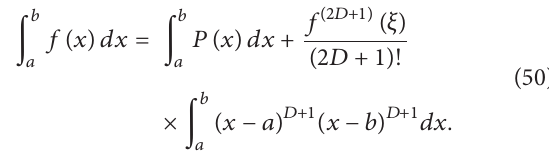
ONC for classical open numerical quadrature rule. ONC1 for open numerical quadrature with derivative at all interior points. ONC2 for open numerical quadrature with derivative at all points including endpoints. ONC3 for open numerical quadrature with derivative used only at interior endpoints. ONC4 for open numerical quadrature with derivative used only at exterior endpoints. Table 1 compares the coefficient of the classical open Newton-Cotes formulas with newly developed open Newton- Cotes formulas with derivatives. The order described in the first column is the order of the composite formula; 𝑁 0 represents the number of nodes. The columns below each heading of the open type quadrature rules represent the coefficients of the error terms. It may be observed from the table that the new method ONC2 has prominently smaller error term coefficients. Tables 2, 3, 4, 5 and 6 show the number of function and derivative evaluations for the classical open Newton- Cotes rules and the new derivative based open Newton-Cotes formulas, as well as their orders of accuracy. These